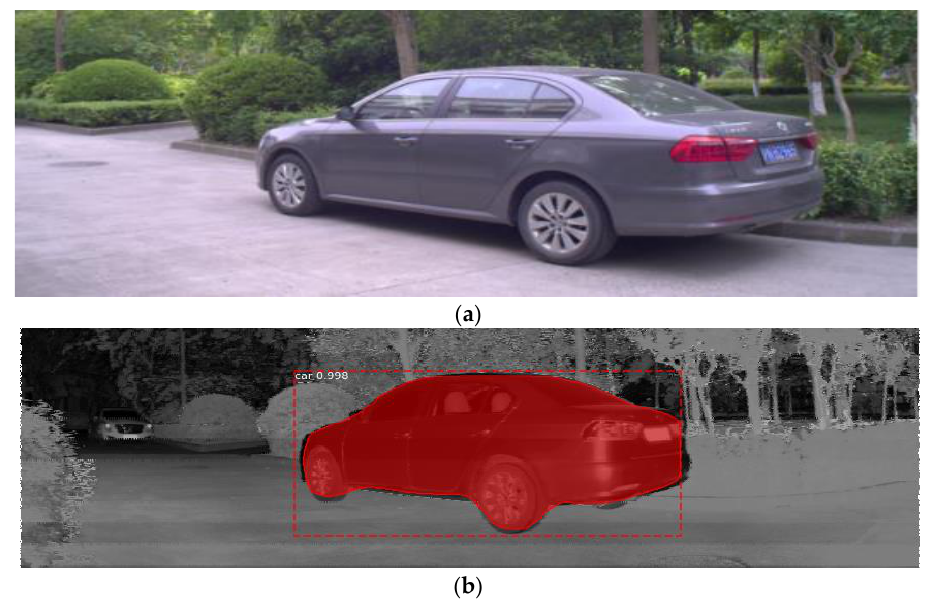
Figure 14. Segmentation result in outdoor experiment: ( a ) the RGB image in the outdoor scene; ( b ) segmentation for the ReV image of a car in the outdoor scene.